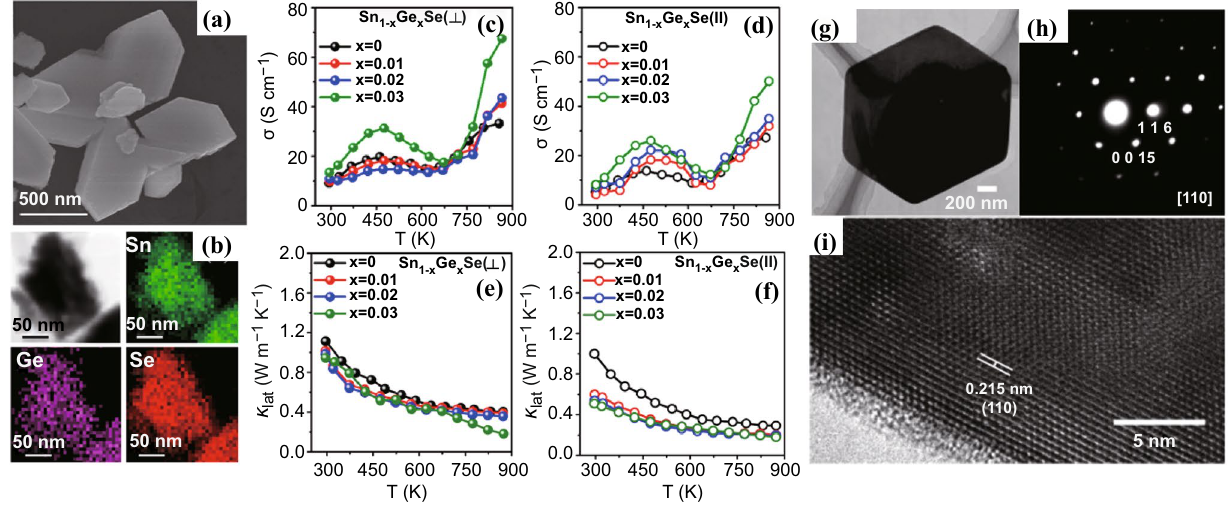
Fig. 13 a FESEM image of Sn 0.97 Ge 0.03 Se nanoplates. b STEM image of Sn 0.97 Ge 0.03 Se nanoplates along with EDAX color mapping for Sn, Ge, and Se. Temperature-dependent c , d electrical conductivity and e , f lattice thermal conductivity of Sn 1− x Ge x Se measured parallel (open symbols) and perpendicular (solid symbols) to the SPS pressing direction, respectively. g TEM image, h SAED pattern and i HRTEM image of a single Sb 2 Te 3 nanoplate. Adapted with permission from Refs. [192,